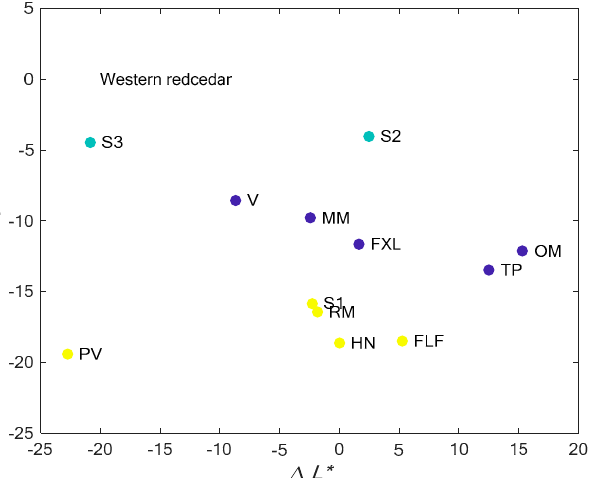
Figure 16. Cluster results according to linkage distance calculated with MANOVA using 18-month Δ L *, Δ a *, and Δ b * values for western redcedar wood.